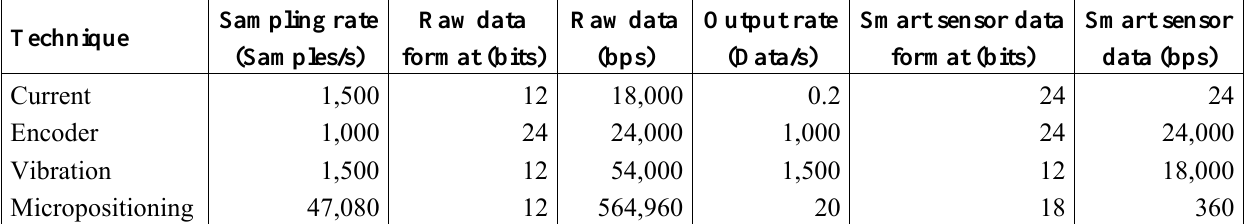
Table 5. Network utilization for raw data and processed data